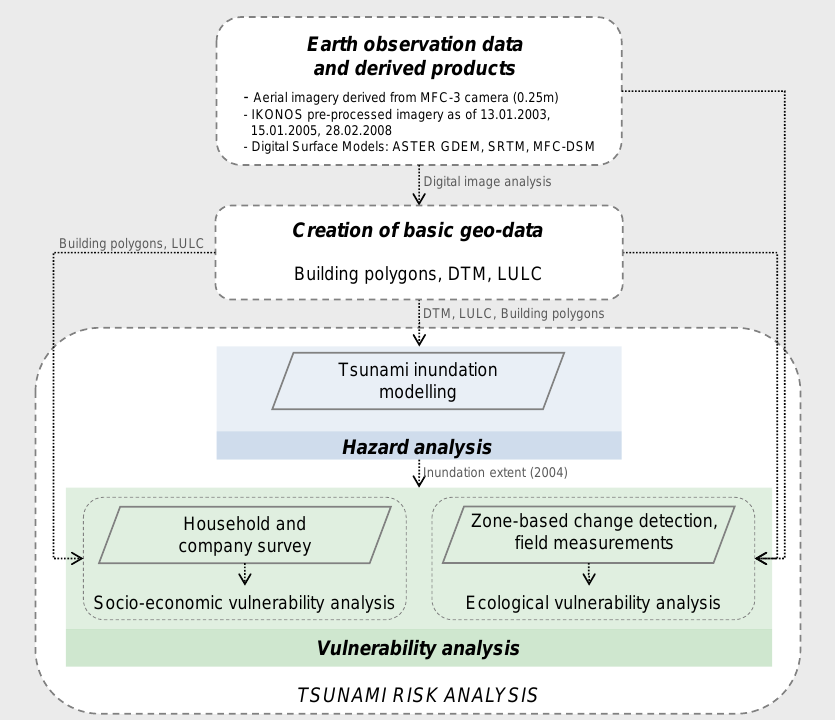
Fig. 2. Methodological concept